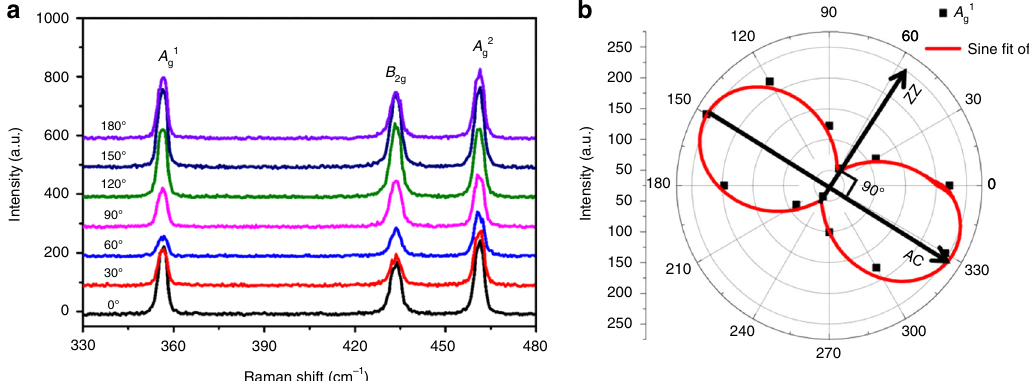
Fig. 2 Polarization-resolved Raman scattering spectrum. a Raman curves with different incident angles from 0° to 180° with a 632 nm laser. b Polar plots of the fi tted peak intensities of the A g 1 modes as a function of sample rotation angle under parallel cross-polarization con fi